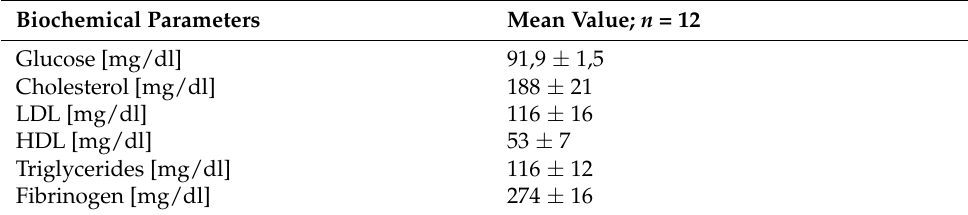
Table 2. Mean values of biochemical parameters in the study group LDL and HDL stand for low- and high-density lipoprotein, respectively.